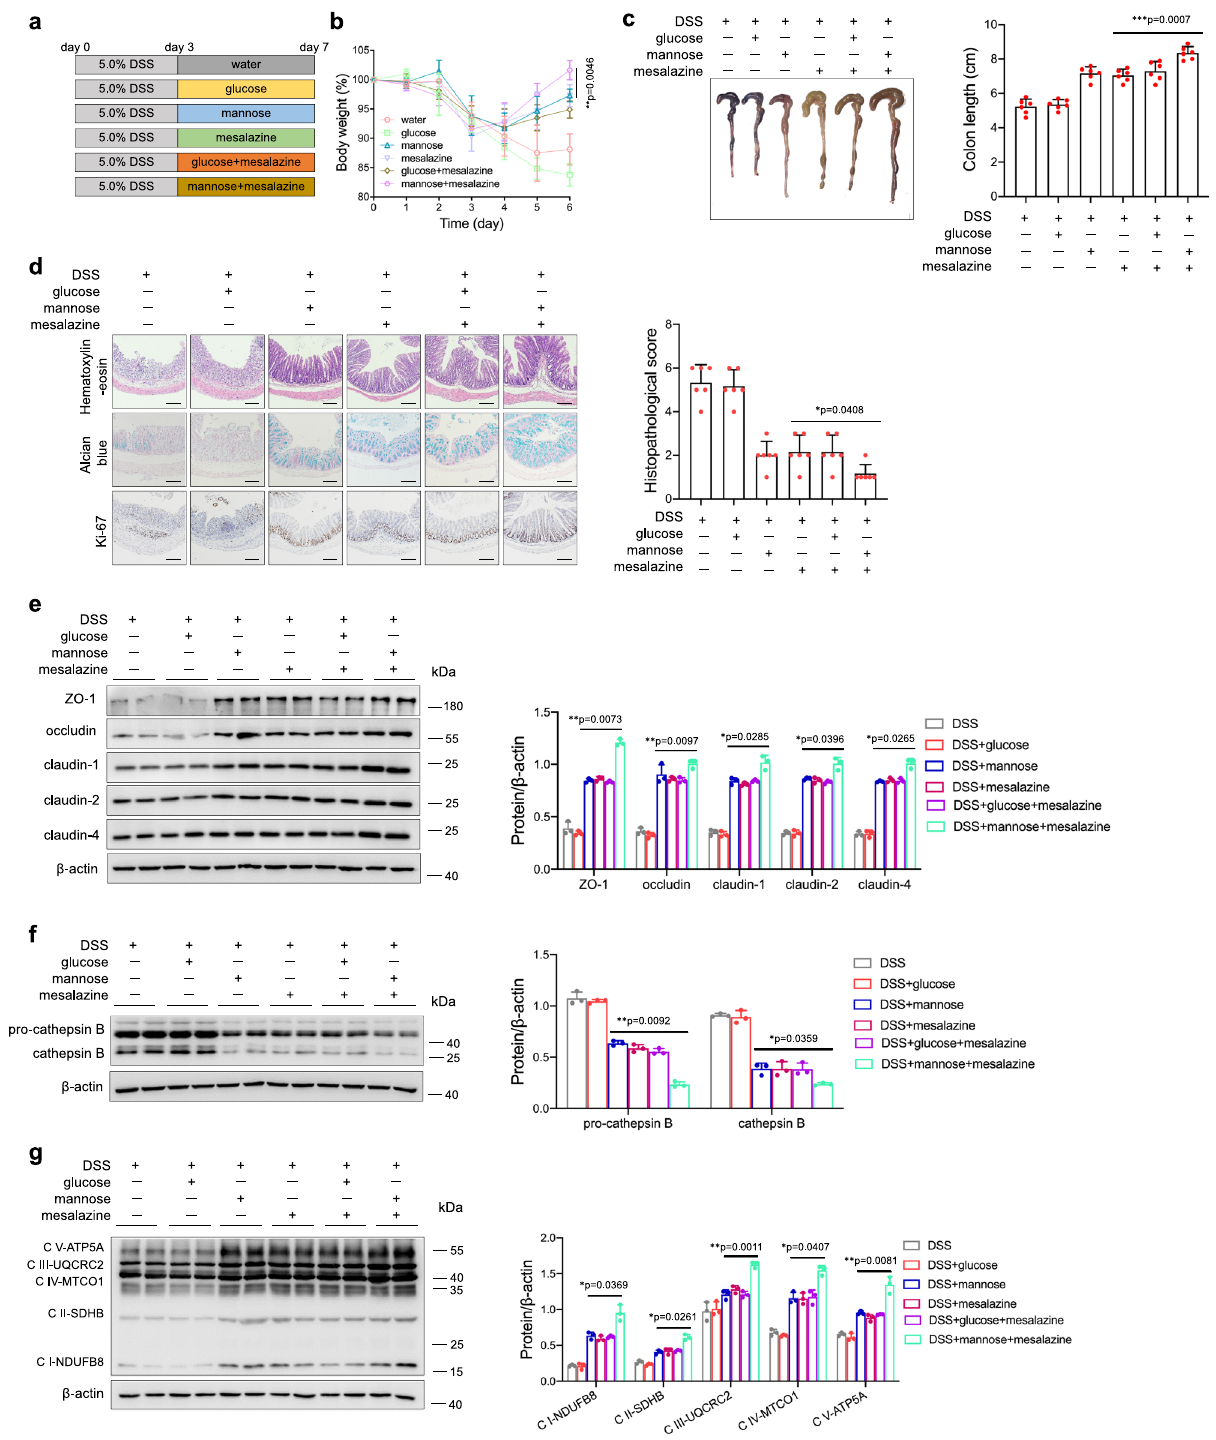
Fig. 7 | Mannose exerts a therapeutic effect against DSS-induced colitis. a Schematicoverviewoftheexperimentaldesign. b – g Mice(male, n =6pergroup) were administered 5.0% DSS from day 0 to day 3, followed by treatment with mannose and mesalazine either alone or in combination from day 4 to day 7. b Changes in body weights during the experiments were recorded. c Colon tissues wereisolatedonthelastdayoftheexperiment.Arepresentativephotographofthe colon tissue from each group is presented, and the colon length was measured. Scalebar=1cm. d Histologicalanalysis of mousecolon tissue taken on thelastday of the experiment was performed by H&E, alcian blue, and Ki67 staining. Scale